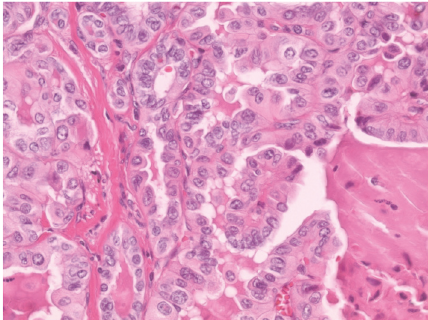
Figure 6: High-power view of the tumor, demonstrating cells with nuclear grooves, peripheralization of chromatin, and some prominence of nucleoli, diagnostic of papillary thyroid carcinoma (H&E stain, 400x original